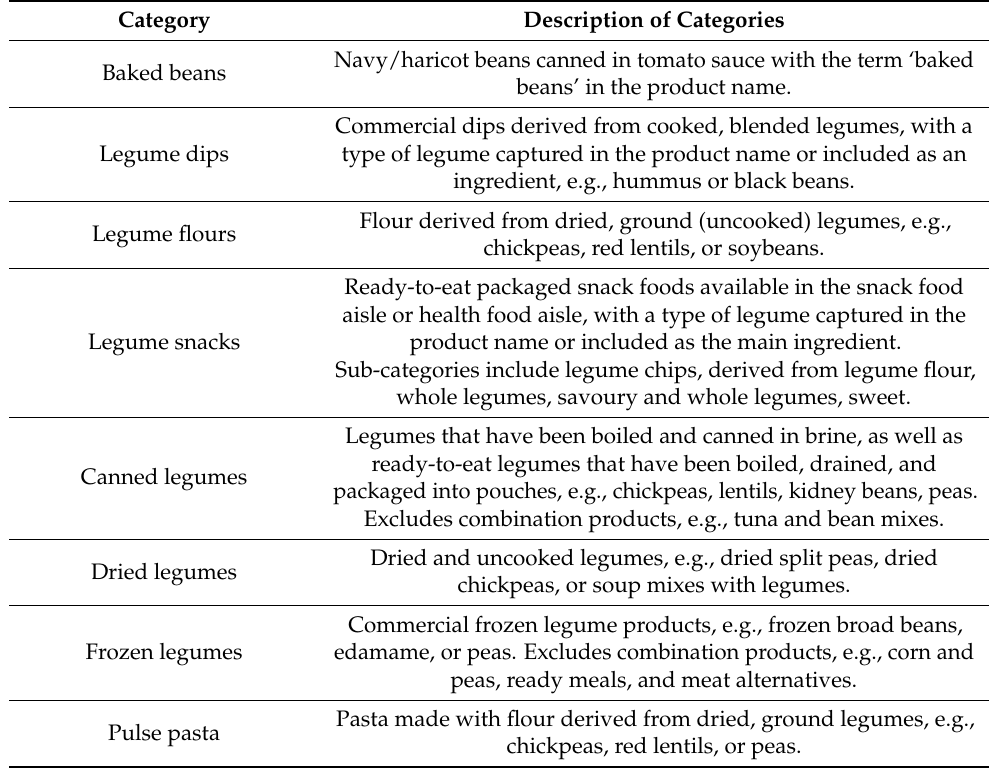
Table 1. Classification and description of legume product